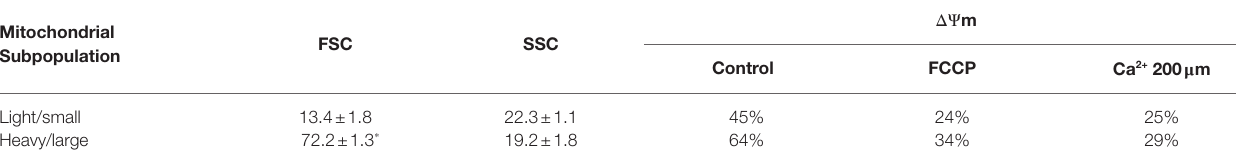
TABLE 2 | Flow cytometry characterization and mitochondrial membrane potential in isolated mitochondrial fractions.